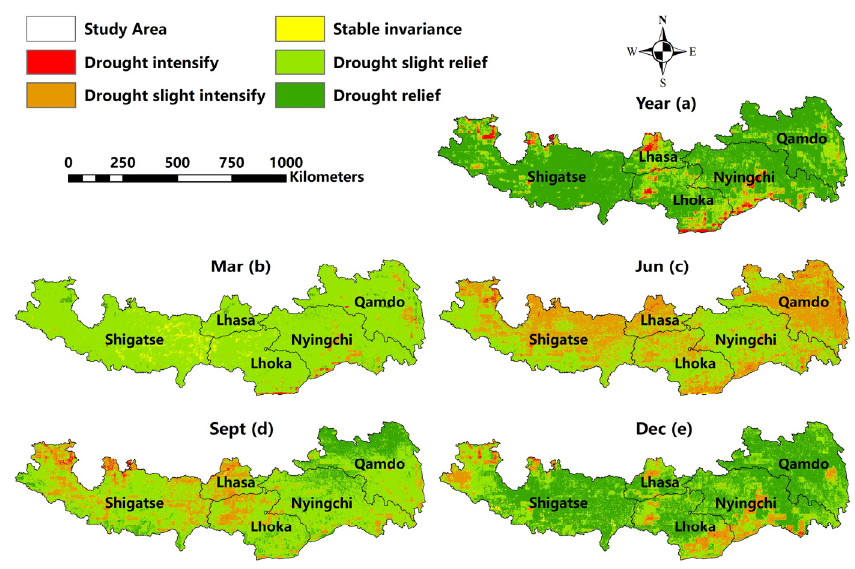
Figure 7. Spatial distribution of the TVMPDI trend level from 2003 to 2018; ( a ) interannual variation; ( b ) variation in March; ( c ) variation in June; ( d ) variation in September; ( e ) variation in December.